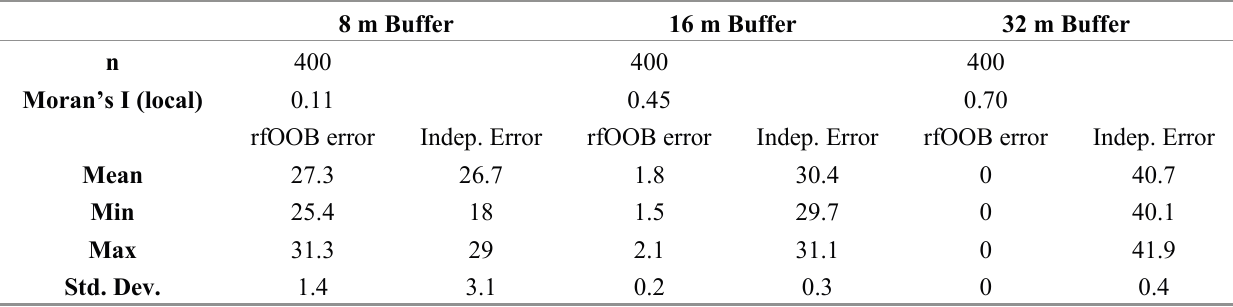
Figure 10. Difference between the actual and predicted proportions of each class in the classification when the proportion of training data used for each class was manipulated. Table 6. rfOOB and independent assessment error based on classifications with varying levels of spatial